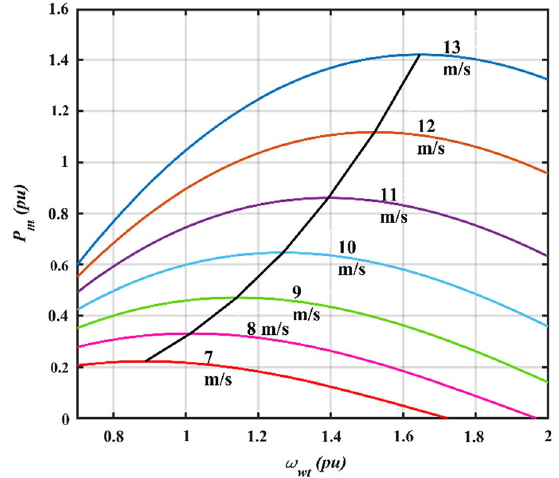
Fig. 3 Output mechanical power of the proposed type 3 wind turbine at certain rotational speed for different wind